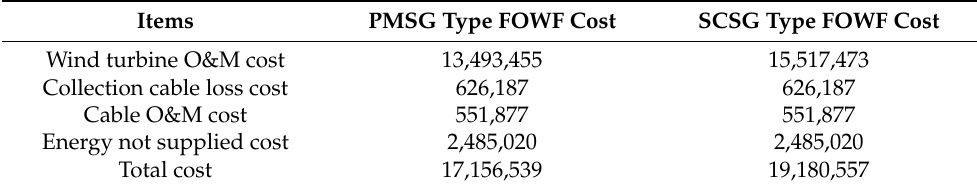
Table 13. OPEX of the PMSG and SCSG types FOWFs (unit: